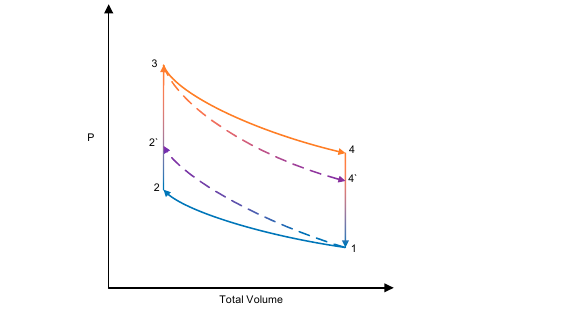
Figure 2. Pressure volume (PV) diagram of the Stirling engine ideal adiabatic cycle 1-2‘-3-4‘ and the ideal isothermal cycle 1-2-3-4.